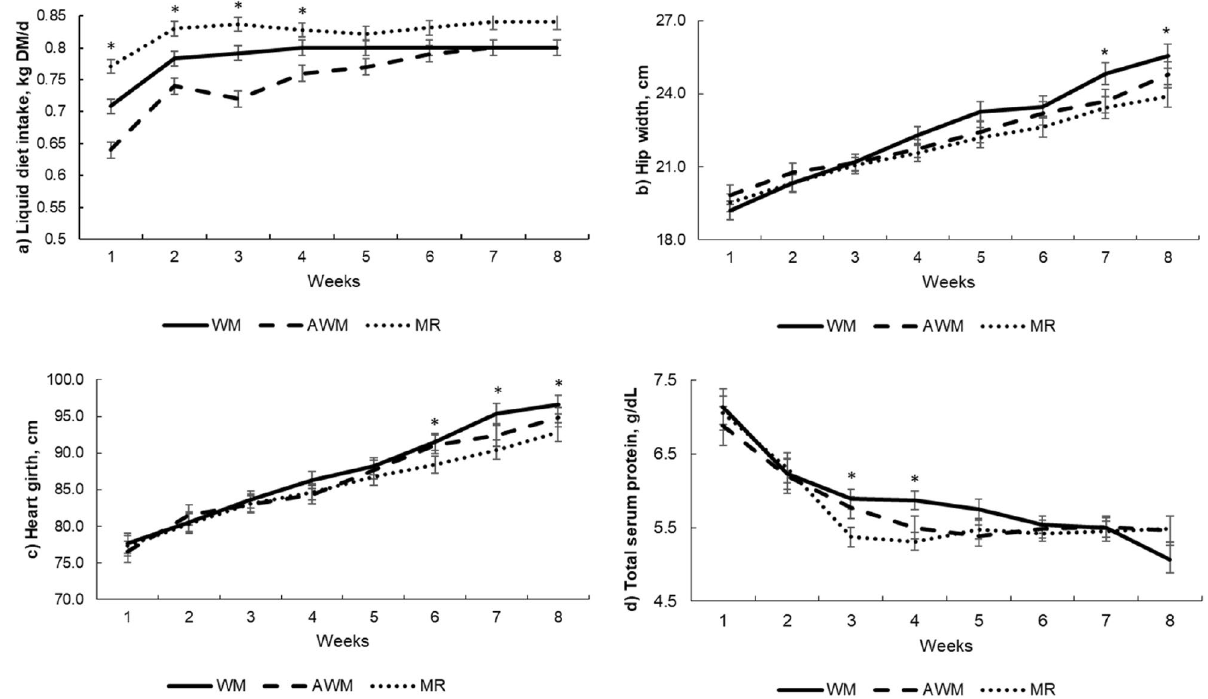
Figure 1. Intake, performance, and blood parameters of dairy calves fed different liquid diets. ( a ) Consumption of liquid diet; ( b ) hip-width; ( c ) heart-girth, and ( d ) total serum protein. *Denotes statistical difference P < 0.05 for the lowest values for AWM in ( a ); and WM higher than MR in ( b )–( d ).